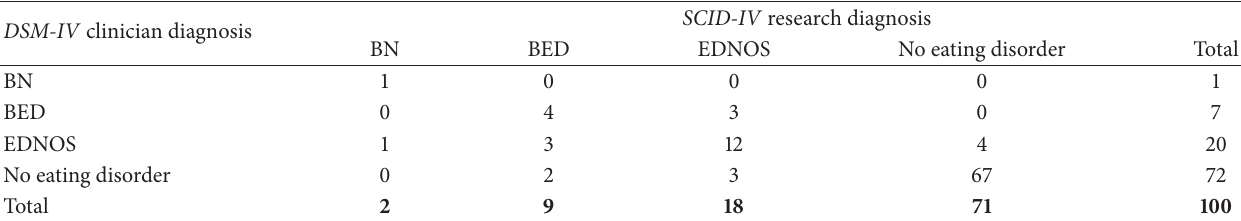
Table4:Eatingdisorderdiagnosesconferredbystructuredinterviewfor DSM-IV (SCID-IV)versusroutineclinicalinterviewinanoutpatient weight-loss seeking